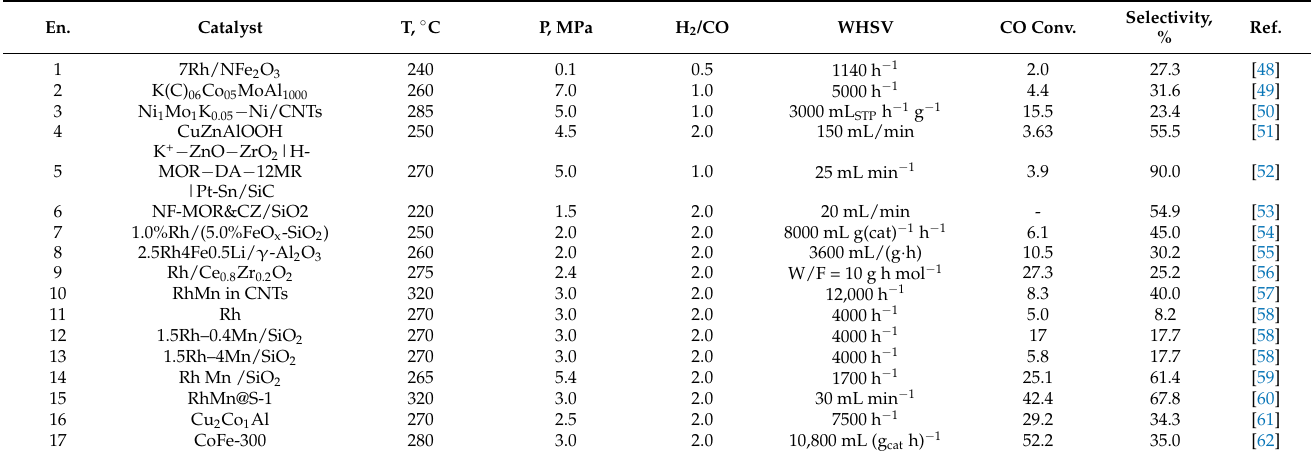
Figure 7. ( a ) Cu-Zn-Al/H-ZSM-5-catalyzed synthesis of MA from syngas; ( b ) a possible reaction pathway for formation of AA; ( c ) ZnAl 2 O 4 │ H-MOR │ ZnAl 2 O 4 combination-catalyzed synthesis of ethanol from syngas. Table 2. Chemocatalytic conversion of biomass-derived syngas to ethanol.